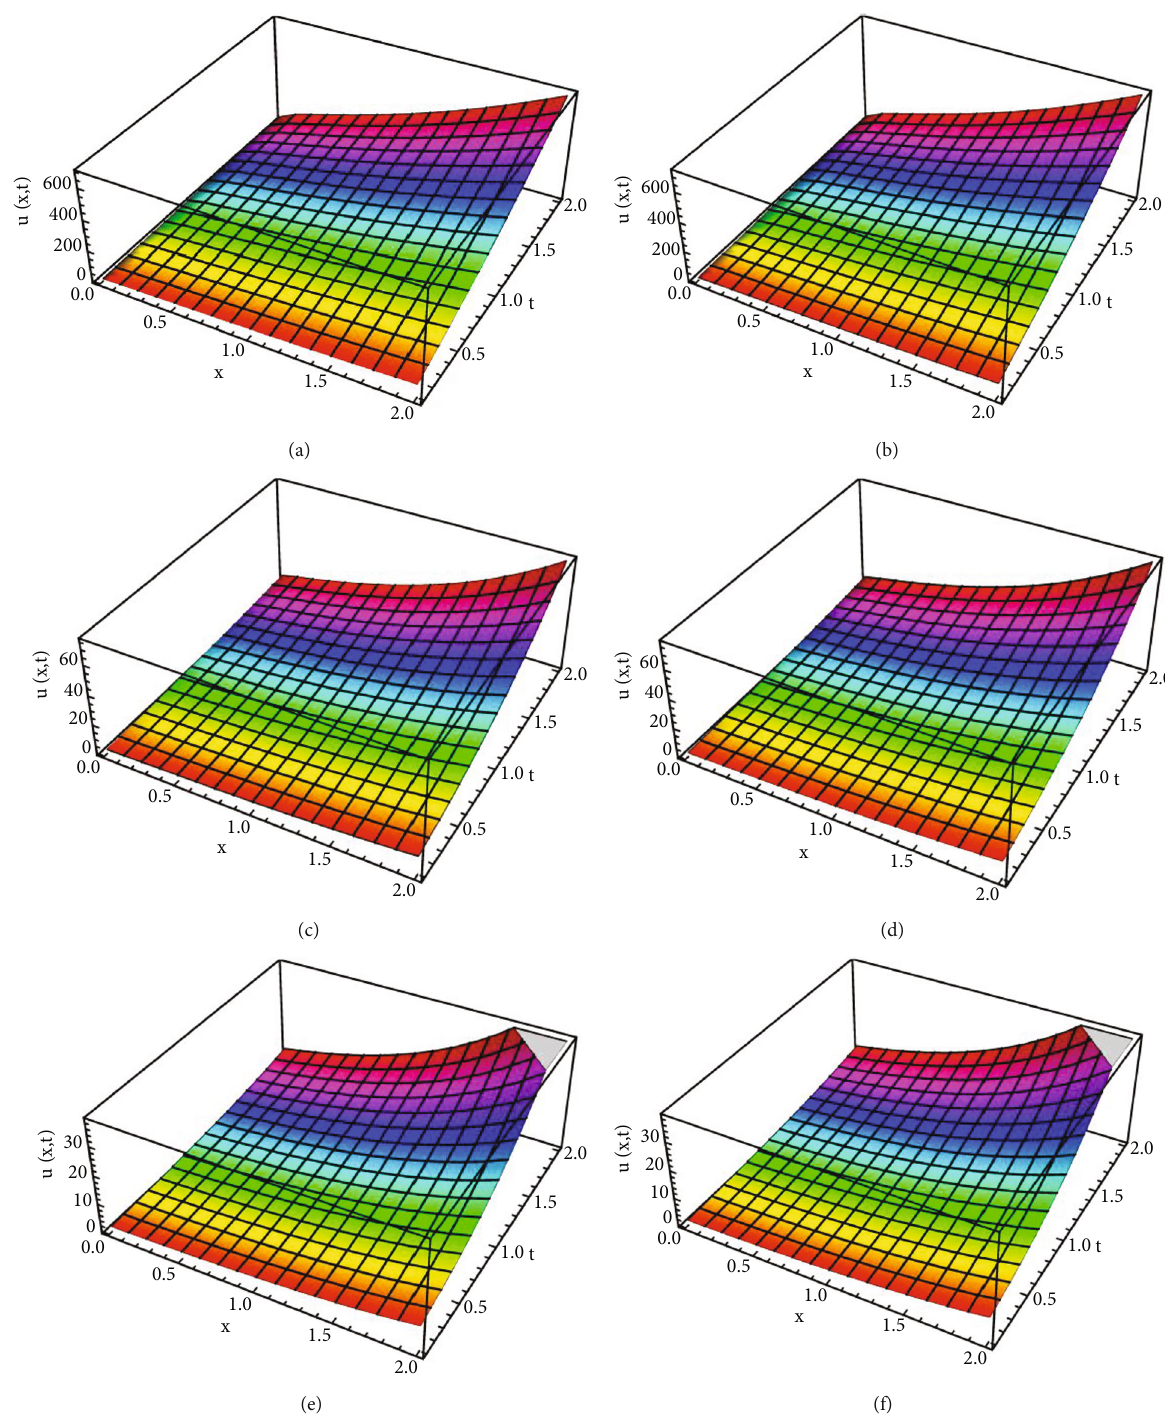
Figure 1: 3D solution plots of Example 1 obtained by the present method (a, c, e) in comparison with the exact solutions (b, d, f) at α = β = 0 : 4 , 0.8, and